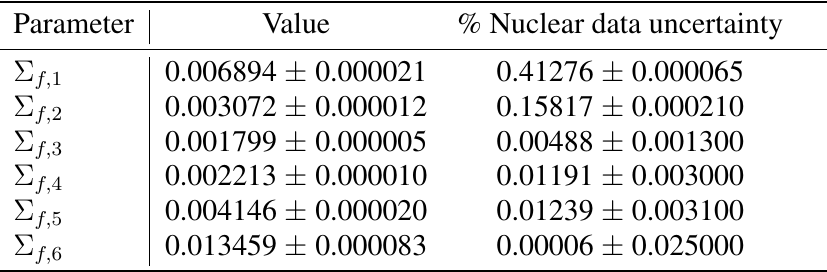
Table 3: Values computed by xGPT and percentage relative standard deviations due to the uncertainties in MT18-MT102 reactions for